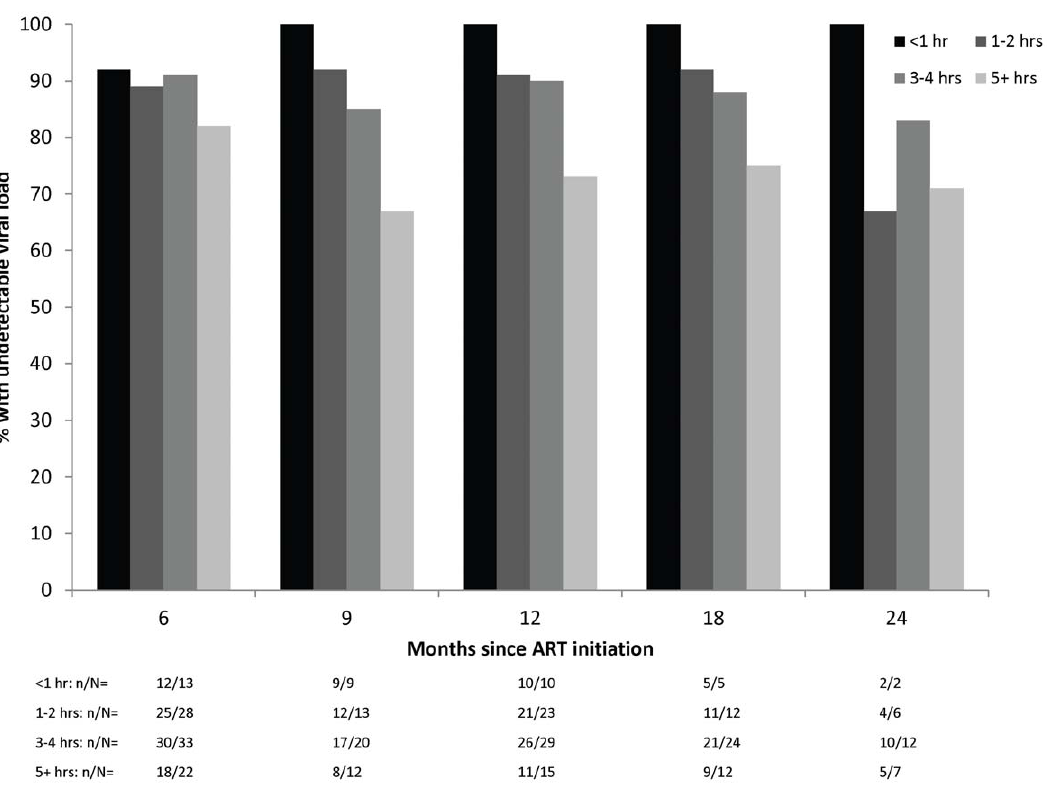
Figure 2. Percentage of children achieving viral suppression after 6 months of ART, by travel time.